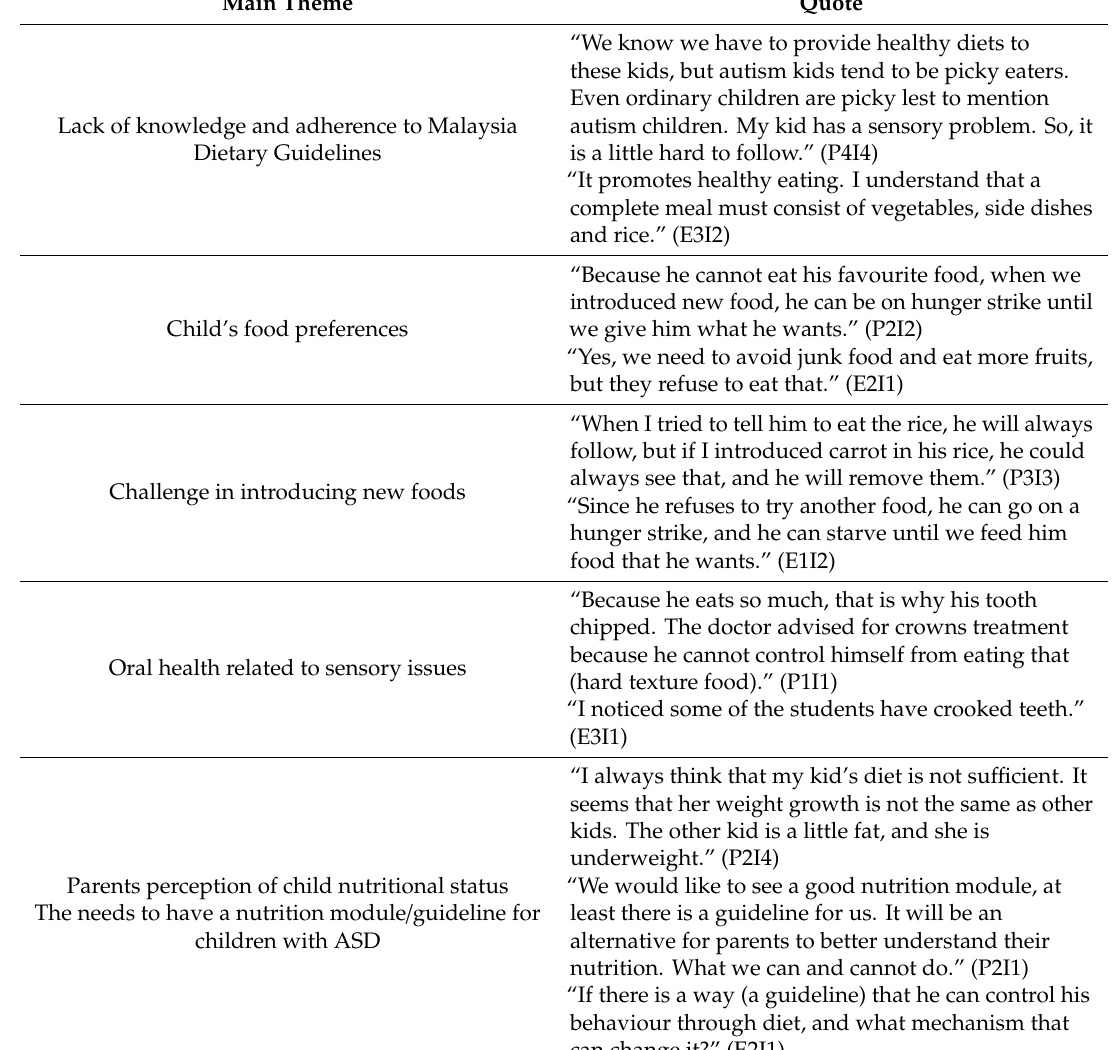
Table 3. Quotes from di ff erent FGD sessions to highlight the main